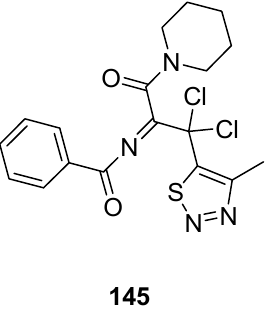
Figure 28. Antifungal activity of triazole moiety containing 1,2,3-thiadiazolew 143 and 144 . Less antifungal activity was observed in the derivative 145 (Figure 29) reported by Tan et al. [155]. Its inhibition rates to Phytophthora infestans (Mont) de Bary, Alternaria solani , Gibberella sanbinetti , Physalospora piricola Nose, Botrytis cinerea , Phytophthora capsici Leonian, Cercospora arachidicola , Rhizoctonia solanii and Fusarium oxysporum reached 32.3, 17.4, 32.3, 25.8, 43.5%, 36.1, 15.8, 30.3 and 26.9% at 50 µ g/mL respectively. The results indicated that the structural motif 145 proved to be broad-spectrum fungicide because it exhibited significant antifungal activity against different fungal strains [155].